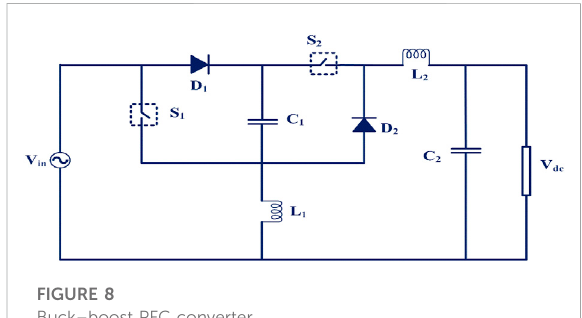
FIGURE 8 Buck – boost PFC converter.